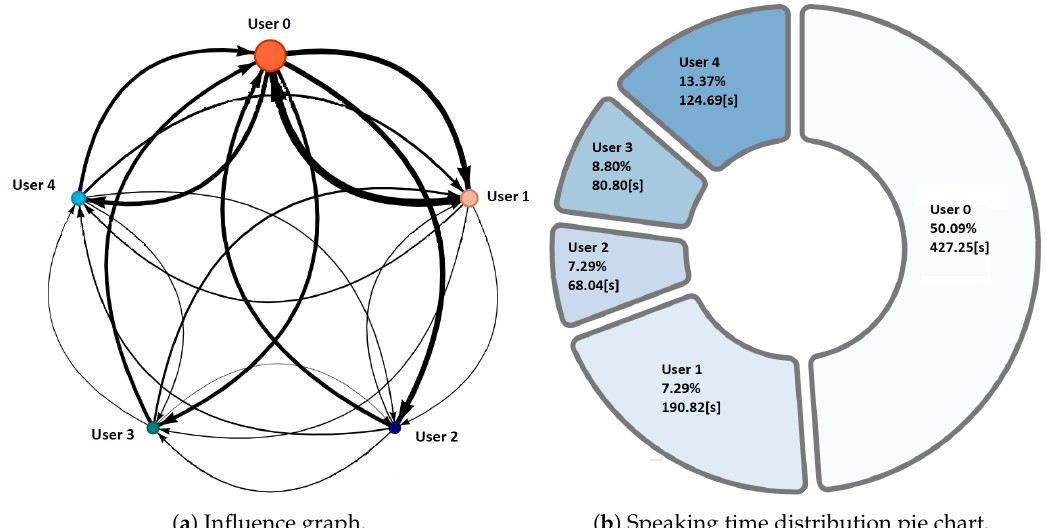
Figure 2. Some visualizations available in NAIRA Web for real time feedback.